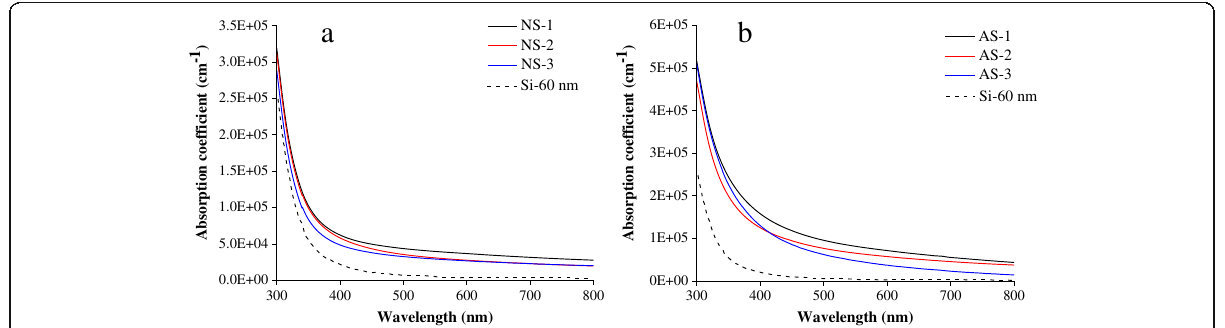
Fig. 1 The absorption coefficient of a NiSi/Si and b AlSi/Si films with various